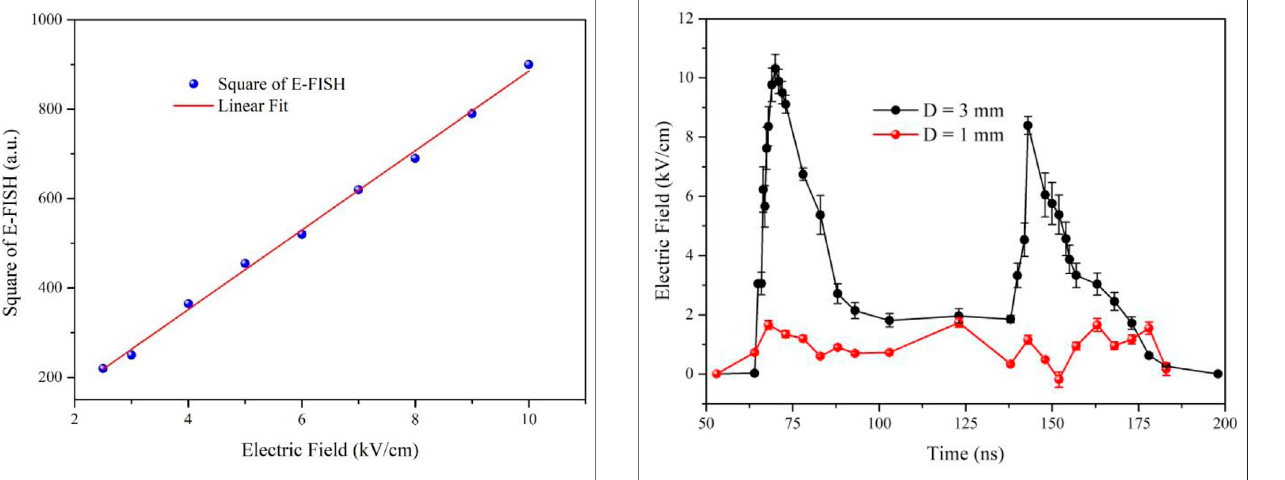
FIGURE 9 | Evolution of the electric fi eld with different diameter